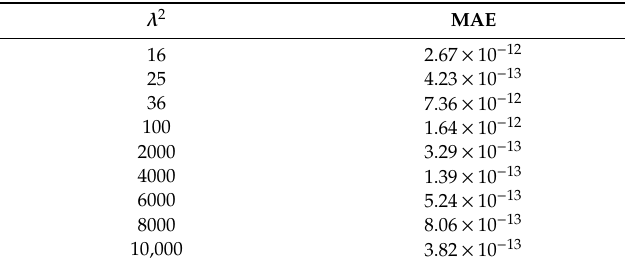
Figure 13. Results comparison between this study and the analytical solution. Table 4. Maximum absolute error for di ff erent λ 2